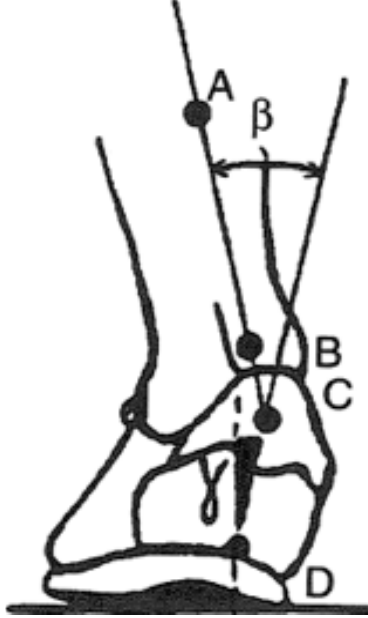
Figure 1 – Illustration of the markers at the rear part of the left leg and